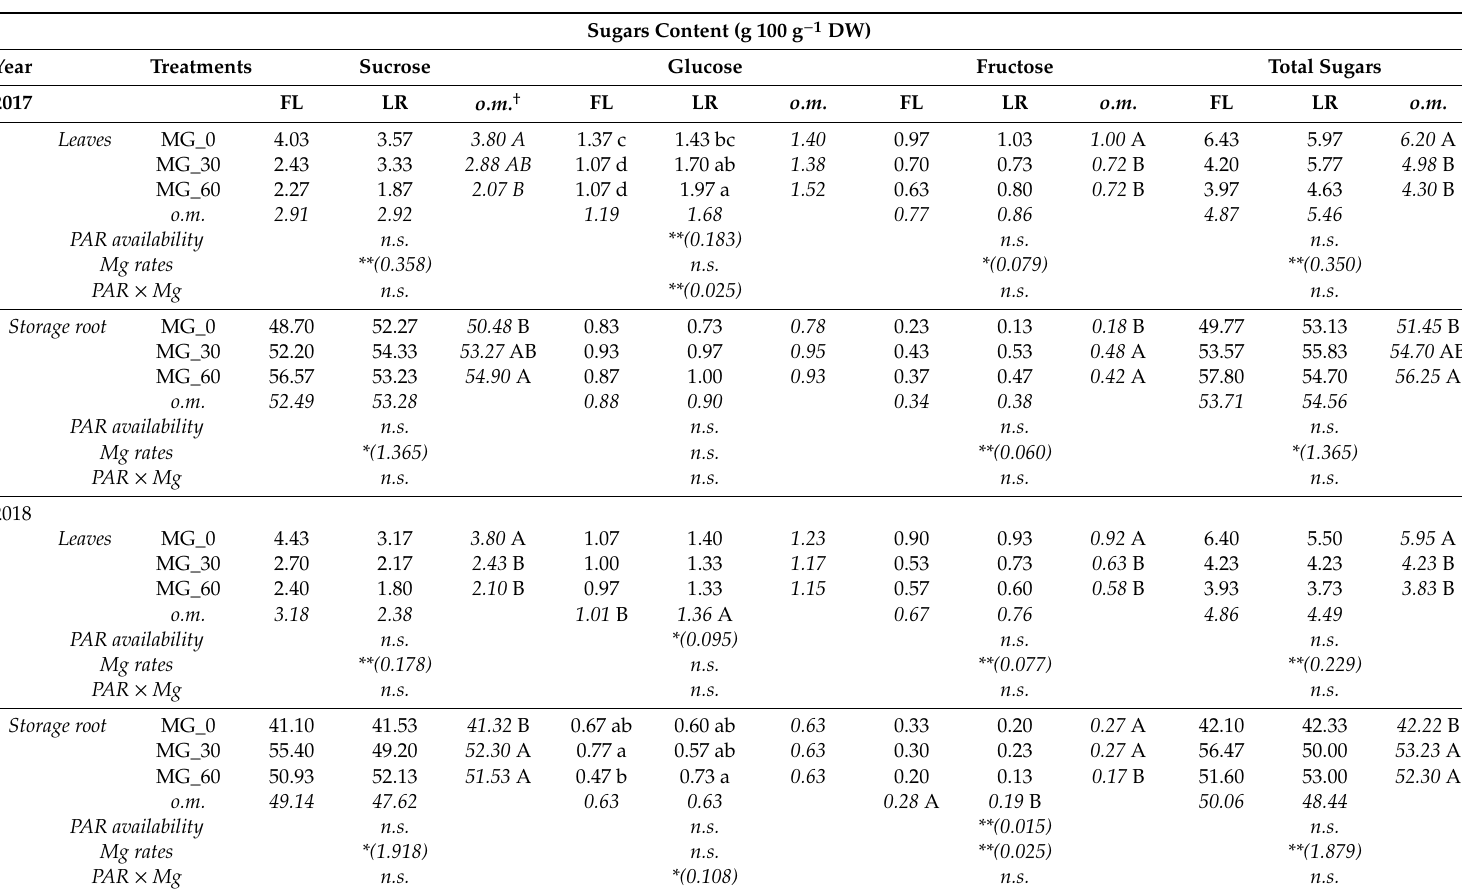
Table 5. Content of individual sugars (g 100 g − 1 DW) in leaves and storage root of red beet plants subjected to two levels of photosynthetically active radiation (PAR) availability (100% PAR availability: Full Light, FL; 50% PAR availability: Light Reduction, LR) and three magnesium (Mg) application rates (0 kg ha − 1 of Mg: MG_0; di ff erent letters (upper case letters: main e ff ects; lower case letters: e ff ects of interaction) significantly di ff er (Fisher’s LSD, p ≤